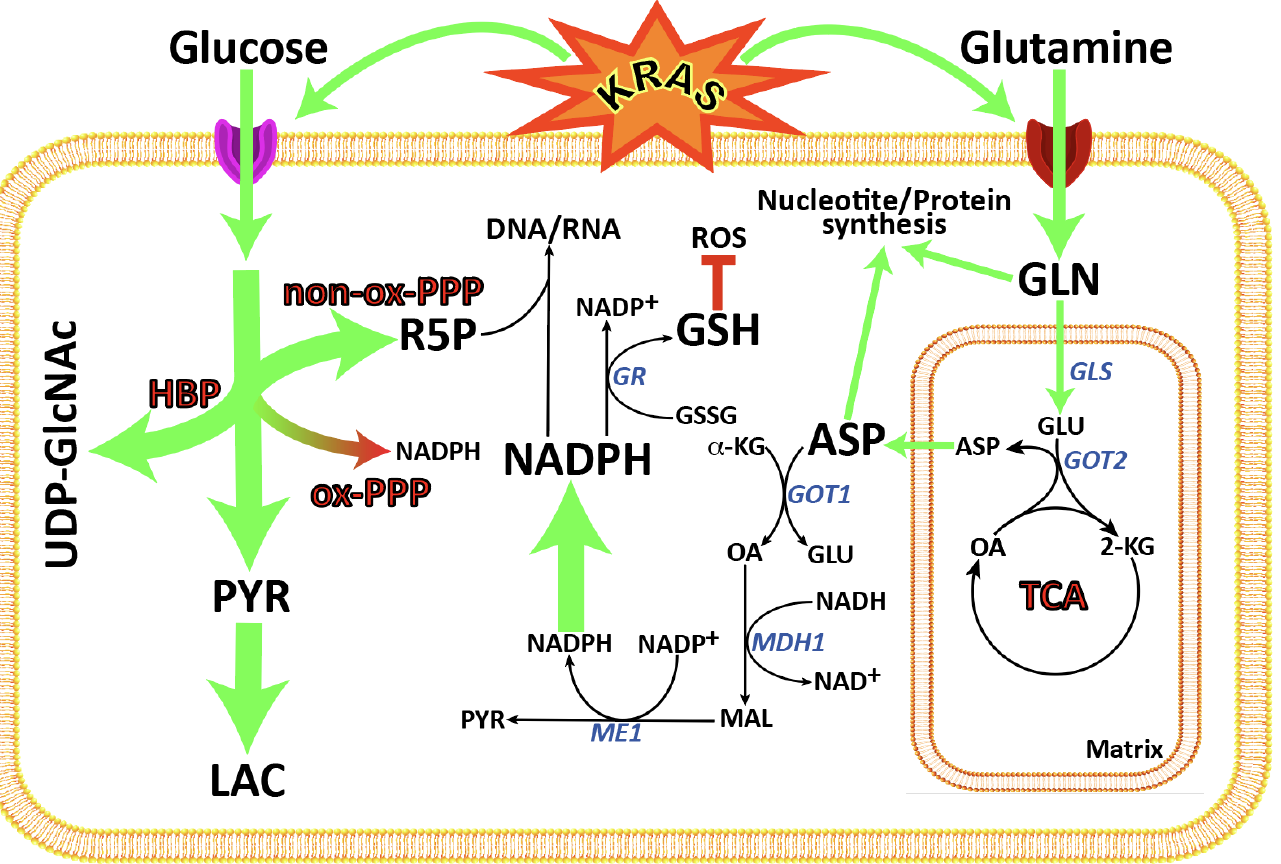
Figure 1. A synopsis of metabolic pathways rewiring in KRAS-mutant PDAC cell lines. KRAS enhances both glucose and glutamine uptake in PDAC cell lines. Glucose is metabolized merely through aerobic glycolysis to produce intermediates used for pentose phosphate and hexosamine pathways as well as lactate. Glutamine can directly be used for protein and nucleotide synthesis or fluxed into mitochondria where it is converted to aspartate by the action of glutaminase and GOT2. Produced aspartate is transported to the cytosol where it is incorporated into protein or used for synthesis of nonessential amino acids and nucleotides. PDAC cells use aspartate for the generation of NADPH and reduced glutathione by action of GOT1, MDH1, and ME1 to control the redox homeostasis. HBP, hexosamine biosynthetic pathway; PPP, pentose phosphate pathway; TCA, Krebs cycle; GLS, glutaminase; GOT1, glutamate-oxaloacetate transaminase 1; GOT2, glutamate-oxaloacetate transaminase 2; GR, glutathione reductase; MDH1, cytosolic malate dehydrogenase; ME1, cytosolic malic enzyme; α-KG, α-ketogluturate; Asp, aspartate; Glu, glutamate; Gln, glutamine; GSH, reduced glutathione; GSSG, oxidized glutathione; Lac, lactate; Mal, malate; OA, oxaloacetate; Pyr, pyruvate; R5B, ribose-5-phosphate; ROS, reactive oxygen species; UDP-GlcNAc, Uridine diphosphate N-acetylglucosamine.